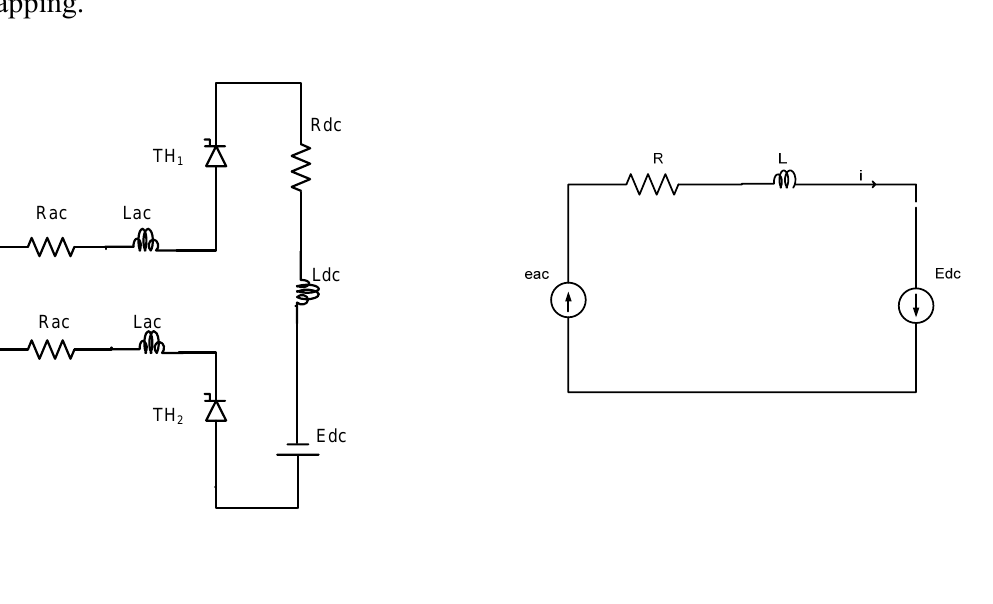
Figure 2. Simplified circuit of Figure 1 if TH1 and TH2 are conducting assuming no